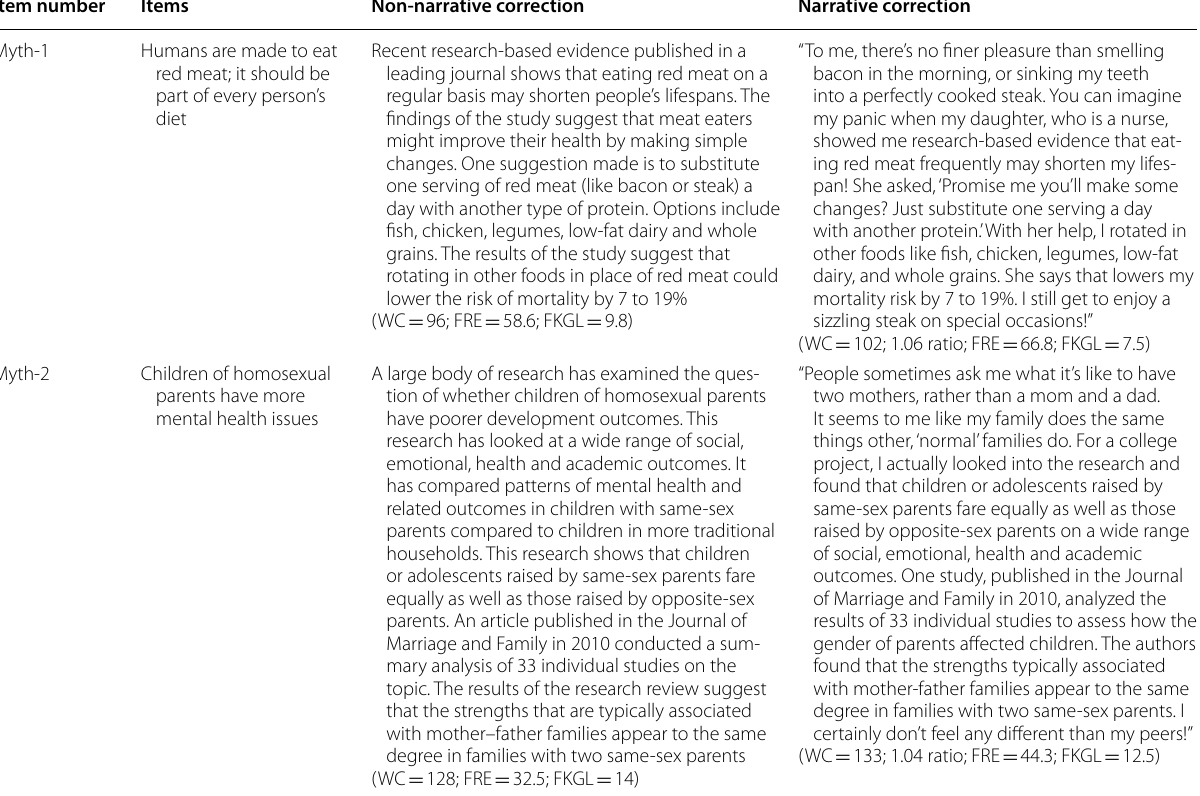
WC, Word Count; FRE, Flesch Reading Ease; FKGL, Flesch–Kincaid Grade Level